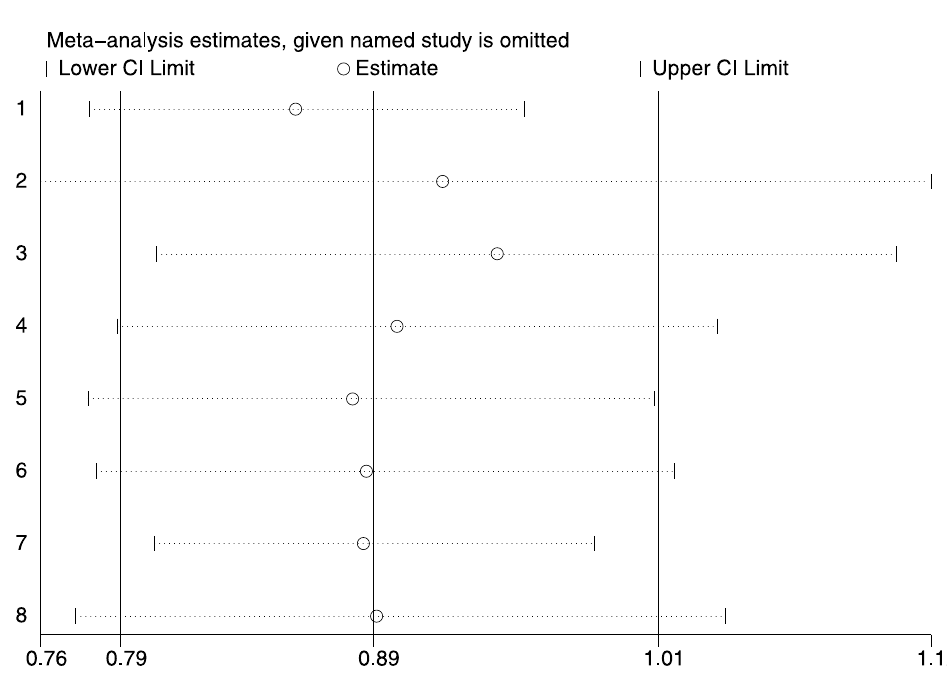
Fig 7. Analysis of influence or sensitivity analysis. Sensitivity analysis showing the influence of individual studies on the summary relative risk. The results are computed by the sequential removal of individual studies. The two ends of every dotted line represent the 95% confidence